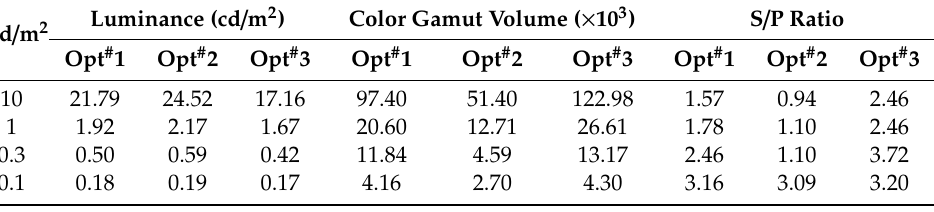
Table 3. Information of optimal spectra.